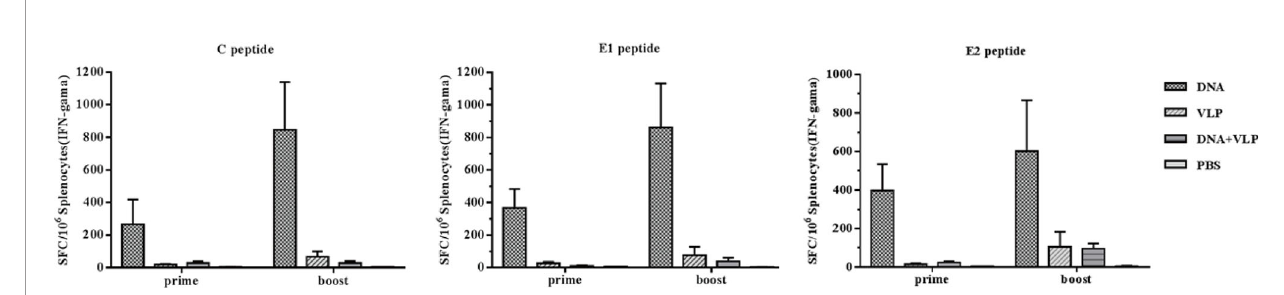
FIGURE 5 | Enzyme-linked immunospot assays of IFN- g secretion in immunized mice. Splenocytes were isolated from mice (n=4) and stimulated with CHIKV C, E1, and E2 peptides at day 14 and 35 after the prime and boost immunization. Splenocytes secreting IFN- g were quanti fi ed using ELISpot assays. The data represent the mean ± standard error [SEM], with units of SFCs per million splenocytes.